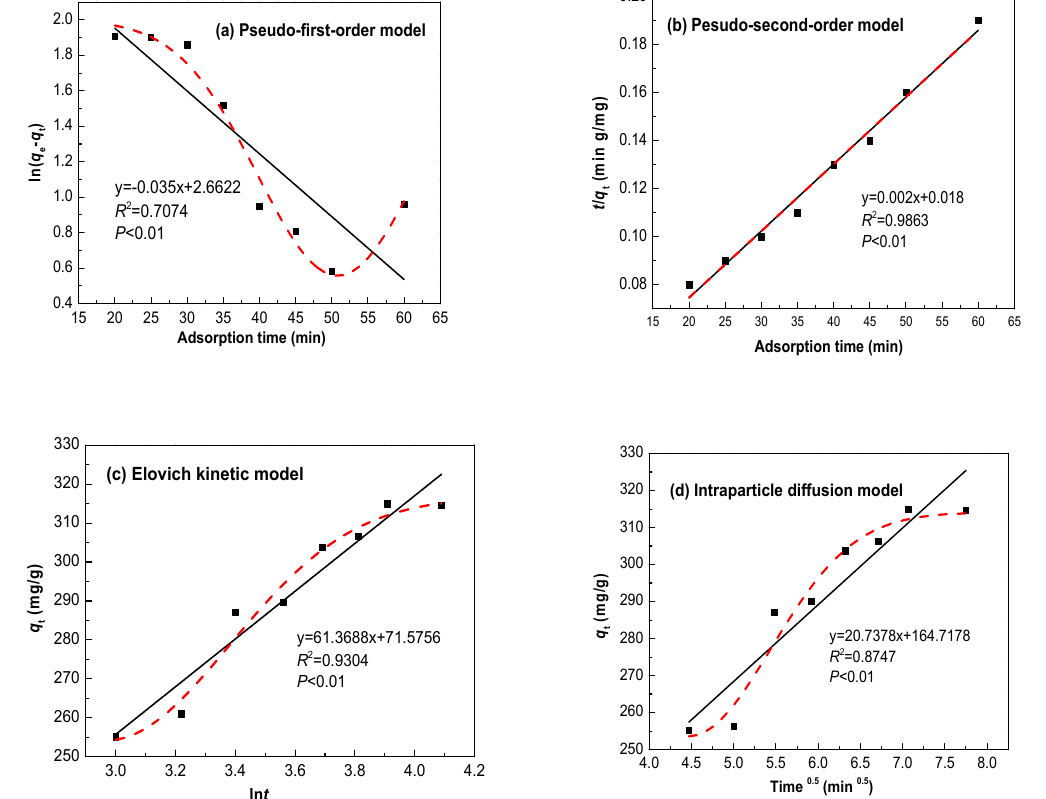
Figure 6. ( a ) Pseudo-first-order, ( b ) pseudo-second-order, ( c ) Elovich kinetic, and ( d ) intraparticle diffusion models for the adsorption of Zn(II) by the Ln@AC nanocomposite. Table 2. R 2 and constant values for the adsorption kinetics models of Zn(II). Adsorption experiments: weight ratio of Ln to AC: 3:1; dosage: 1 g/L; initial Zn(II) concentration: 600 mg/L; pH: 6.8; adsorption temperature: 65 °C; adsorption time range: 20–60 min.